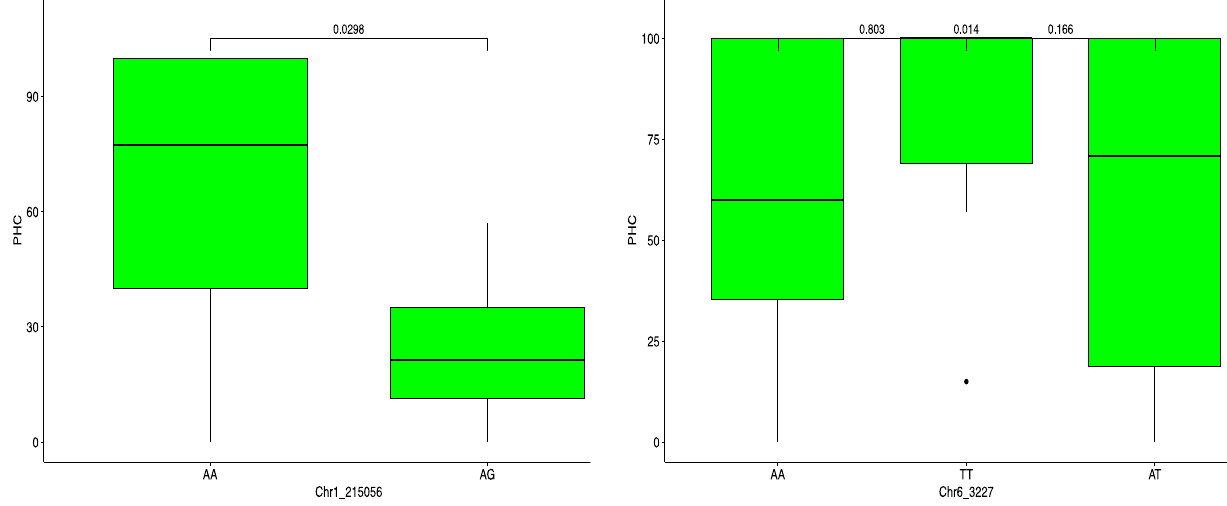
Figure 7. Percentage high crossability (PHC) haplotype segregation in D. alata. The boxplots represent the segregation probabilities for each marker.